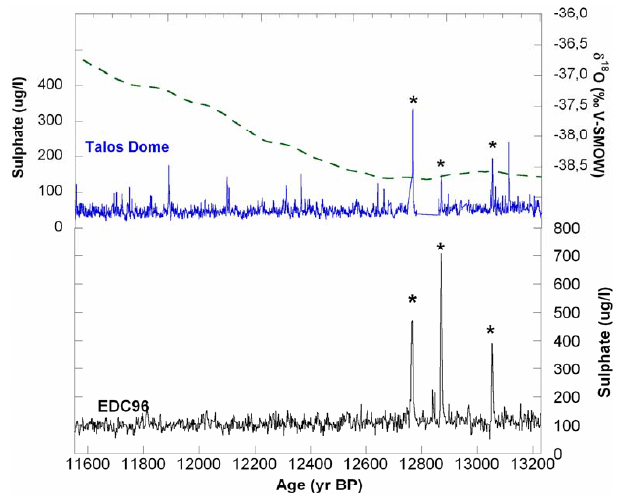
Fig. 5. Synchronised sulphate profiles of the EPICA-DC and Ta- los Dome records during the transition from LGM to the Holocene. Few common volcanic signals are detected. Three major eruptions (marked with *) are shown at the start of the transition and they represent a useful horizon for the synchronisation in this section. The TD δ 18 O smoothed profile (green dashed line) is also shown in order to highlight the significant climatic change in this part of the comparison (from 11.5 to 13.2kyr BP).